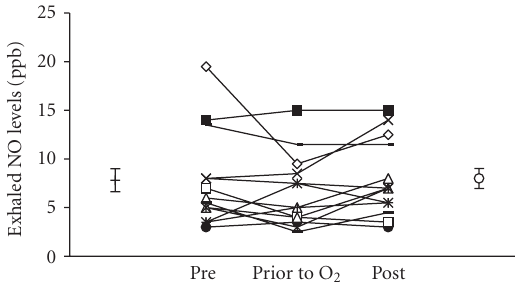
Figure 2: Exhaled nitric oxide levels in 16 normal sta ff members who were exposed to the hyperbaric environment but did not use oxygen until immediately prior to decompression. There were no significant changes between the